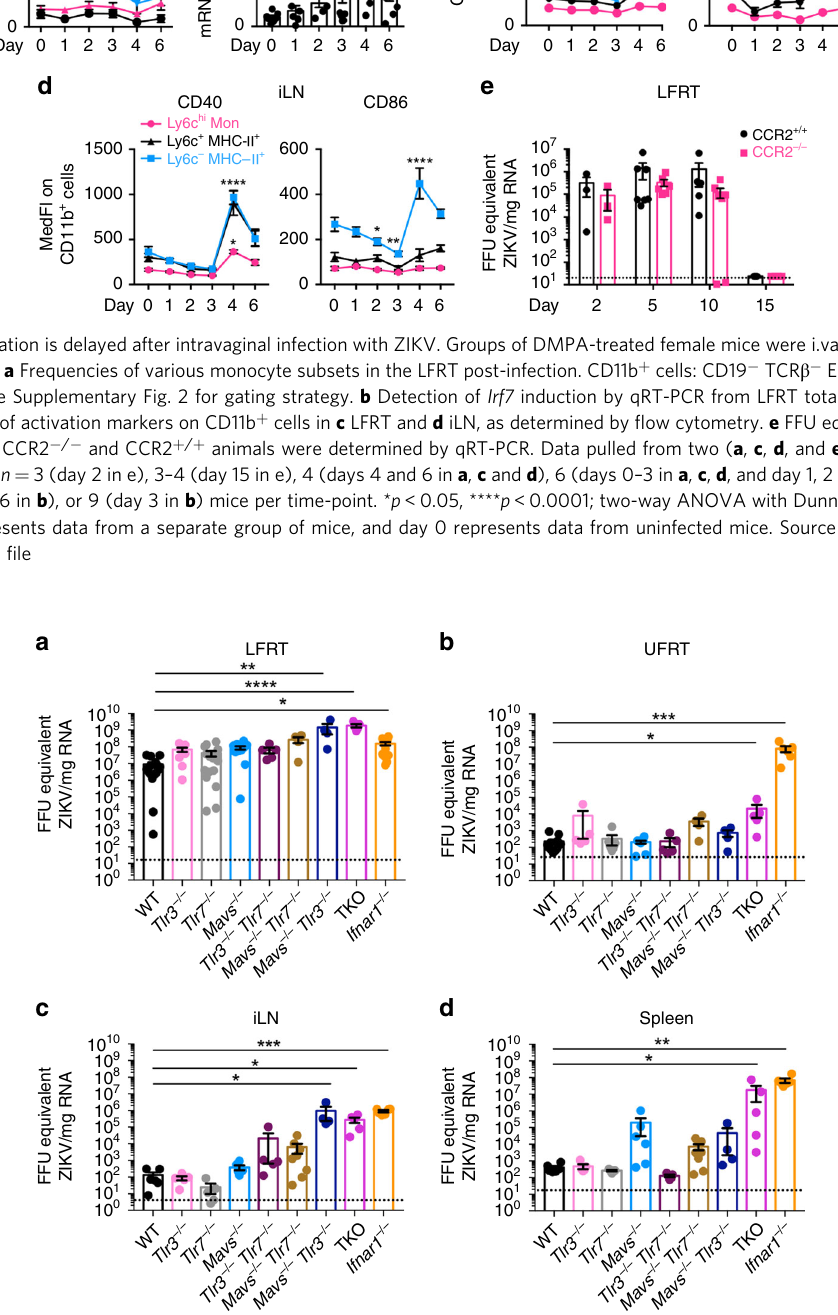
Fig. 3 RNA sensing and IFNAR signaling control ZIKV replication and dissemination. Groups of DMPA-treated female mice were i.vag. inoculated with 2 × 10 4 FFU of ZIKV (PRVABC59). FFU equivalent of ZIKV detected by qRT-PCR from a LFRT (TKO n = 5, Mavs − / − Tlr3 − / − n = 7, Mavs − / − Tlr7 − / − n = 8, Tlr3 − / − n = 9, and Tlr3 − / − Tlr7 − / − n = 10, Mavs − / − n = 11, Ifnar1 − / − n = 14, WT and Tlr7 − / − n = 16 mice), b UFRT ( Mavs − / − Tlr7 − / − and Mavs − / − Tlr3 − / − n = 4, Tlr3 − / − , Tlr7 − / − Tlr3 − / − and TKO n = 5, Ifnar1 − / − n = 6, Tlr7 − / − n = 8, Mavs − / − n = 9, and WT n = 12 mice), c iLN ( Mavs − / − Tlr3 − / − n = 4, Tlr3 − / − , Tlr7 − / − , Tlr7 − / − Tlr3 − / − and TKO n = 5, WT, Mavs − / − and Ifnar1 − / − n = 6, Mavs − / − Tlr7 − / − n = 8 mice), and d spleen ( Mavs − / − Tlr3 − / − n = 4, Tlr3 − / − , Tlr7 − / − , Tlr7 − / − Tlr3 − / − and TKO n = 5, WT, Mavs − / − and Ifnar1 − / − n = 6, Mavs − / − Tlr7 − / − n = 8 mice) of i.vag. infected mice at day 6 post-infection. Data pulled from two independent experiments; mean ± SEM * p < 0.05, ** p < 0.01, *** p < 0.001, **** p < 0.0001; Kruskal – Wallis test with Tukey ’ s multiple comparison test. Each dot represents value from one mouse. Source data for Fig. 3a – d are provided as a Source Data fi